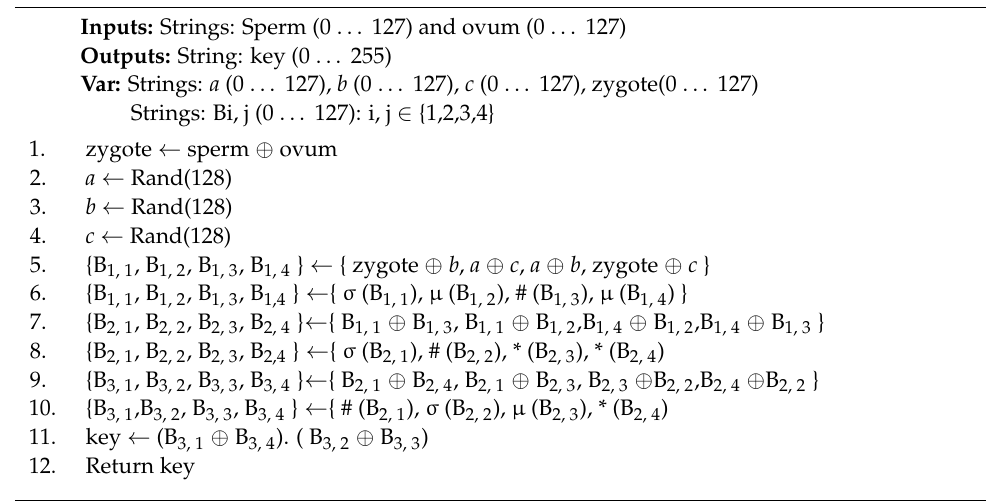
Algorithm 1. Pseudorandom DNA key generation